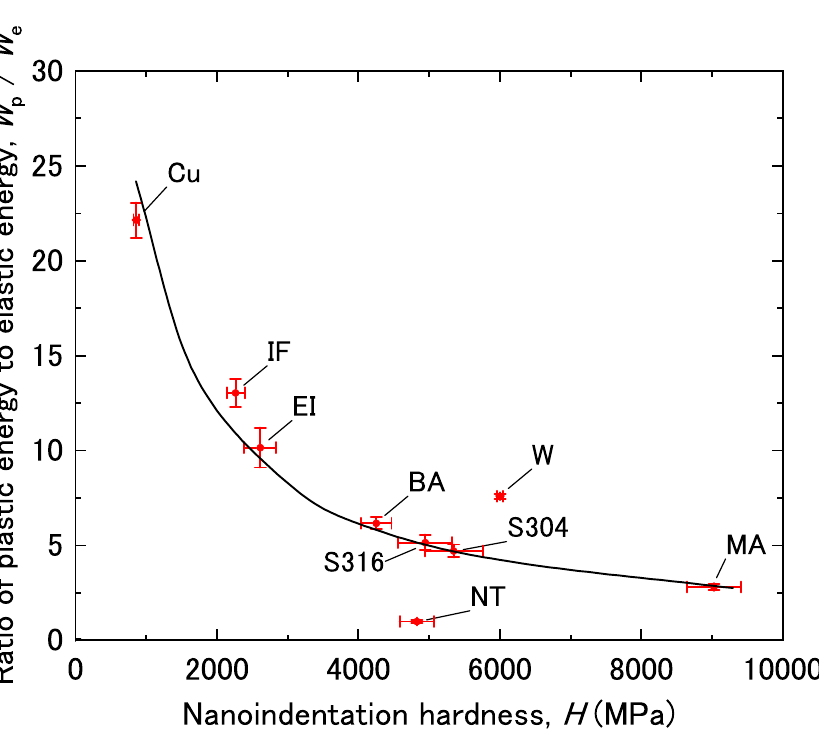
Figure 4. Elastic energy ( W e ) and plastic energy ( W p ) as a function of nanoindentation hardness ( H ). The error bars are drawn with the standard deviation.